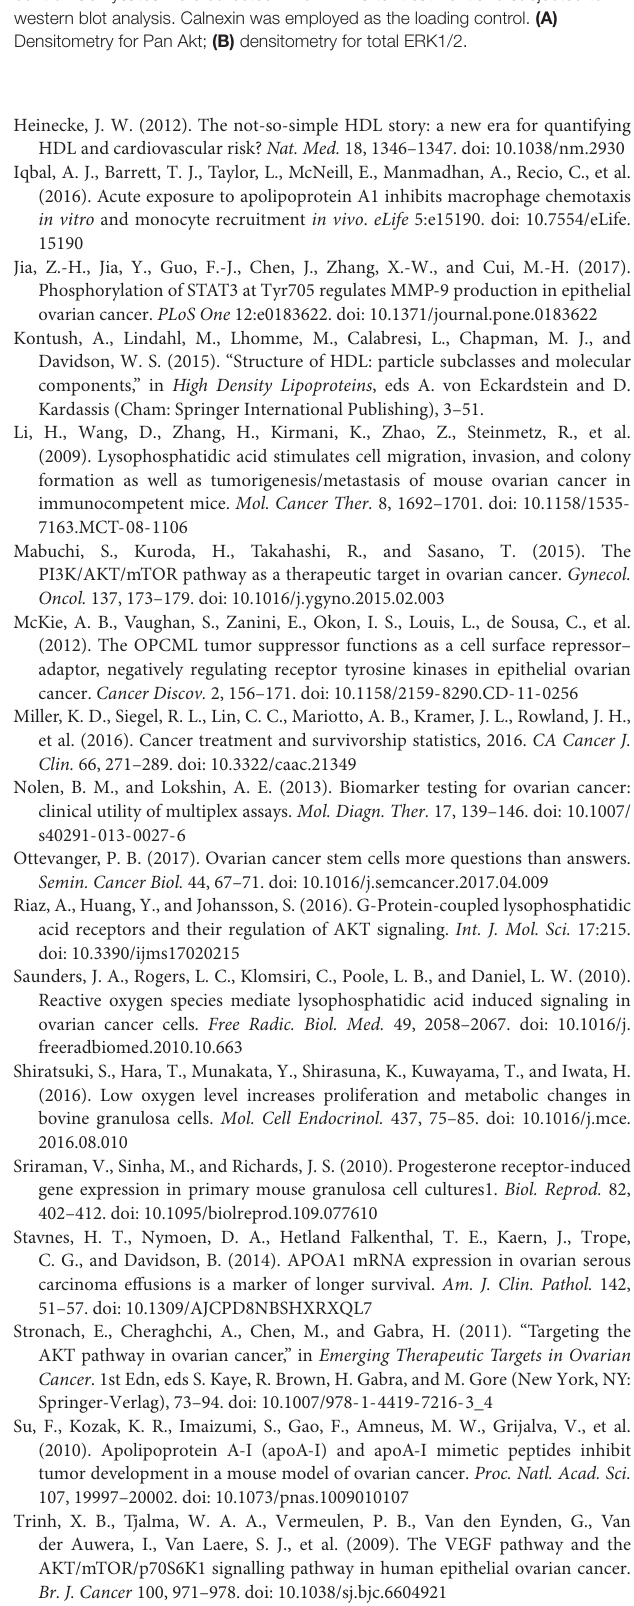
FIGURE S1 | The apoA1 mimetic peptide does not affect the levels of pan Akt or total ERK1/2. SKOV3 cells were treated with the ApoA1 mimetic peptide (50 or 100 µ g/mL) in serum free conditions. Unexposed SKOV3 cells were used as